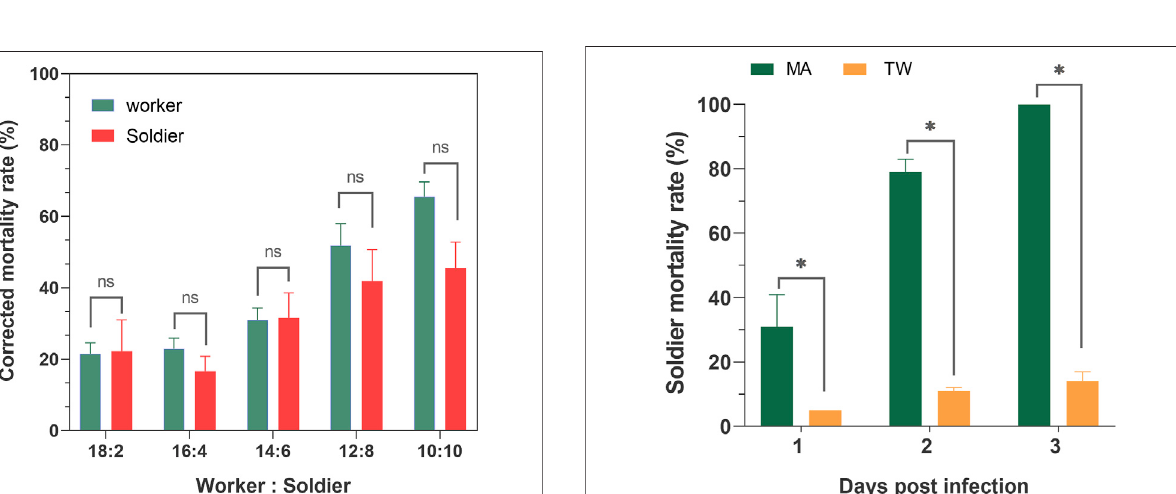
FIGURE 1 | survival curve of the Metarhizium anisopliae- infected worker (A) and solider (B) Coptotermes formosanus in different compositions of worker and soldier ratio under the fi xed group size ( n = 20). The numbers in the legend indicate the speci fi c number of workers and soldiers. The p -values were calculated using the Log-rank (Mantel — Cox) test ( p < 0.05). Nine biological replicates were performed for each composition.